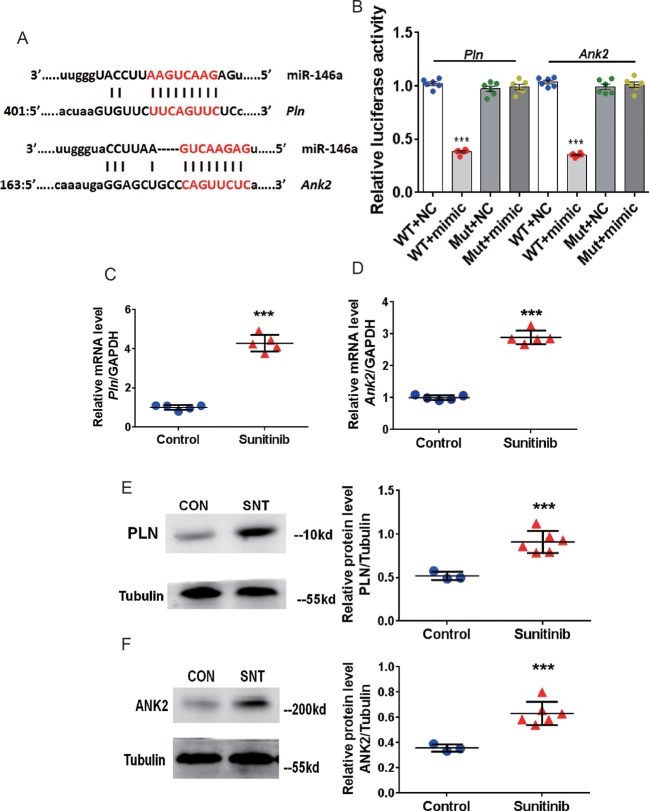
SNT enhanced PLN and ANK2 expression by downregulating miR-146a. (A) Representation of miR-146a and mRNA binding site for the two targets predicted by TargetScan. (B) Relative luciferase activity measured in HEK293 cell (C–D)
Pln and Ank2 mRNA levels after sunitinib treatment. RT-qPCR results were normalized to GAPDH. (E–F) Representative Western Blot bands for PLN and ANK2 protein expression and corresponding summary data after sunitinib treatment. Protein bands were normalized to Tubulin. ***P < 0.001 vs Control.